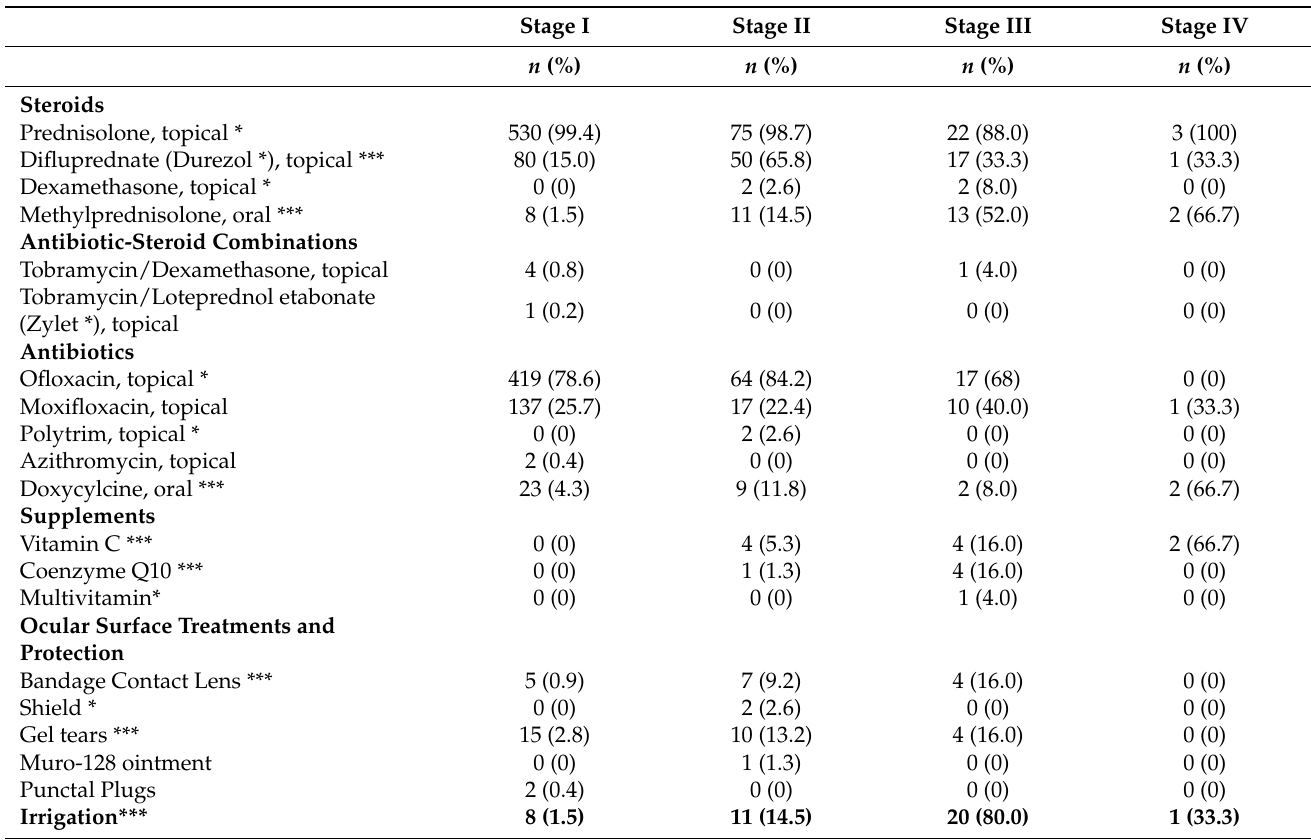
Table 4. Treatments implemented between DLK stages.